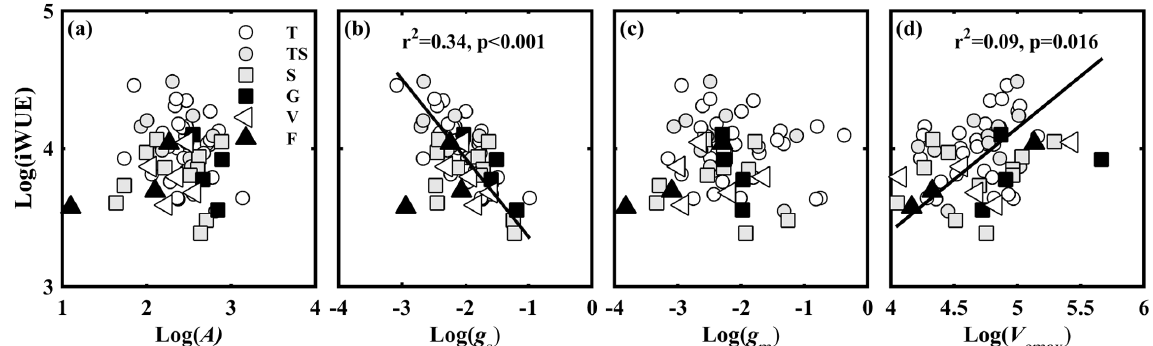
Figure 6. Relationships between the observed intrinsic water use efficiency (iWUE, µmolCO 2 mol − 1 H 2 O) and (a) light-saturated net photosynthesis ( A , µmolCO 2 m − 2 s − 1 ) ; (b) stomatal conductance to CO 2 ( g s , molCO 2 m − 2 s − 1 ) ; (c) mesophyll conductance to CO 2 ( g m , molCO 2 m − 2 s − 1 ) ; and (d) the maximum carboxylase activity of Rubisco ( V cmax , µmolCO 2 m − 2 s − 1 ) . Lines refer to regression line for 63 species. T, TS, S, G, V, and F represent tree, tree/shrub, shrub, grass, vine, and fern, respectively.